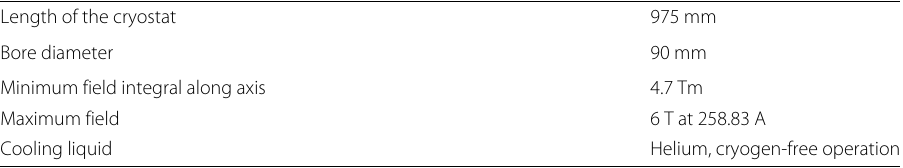
Table 1 Dimensions and characteristics of the Siberian snake at COSY Length of the